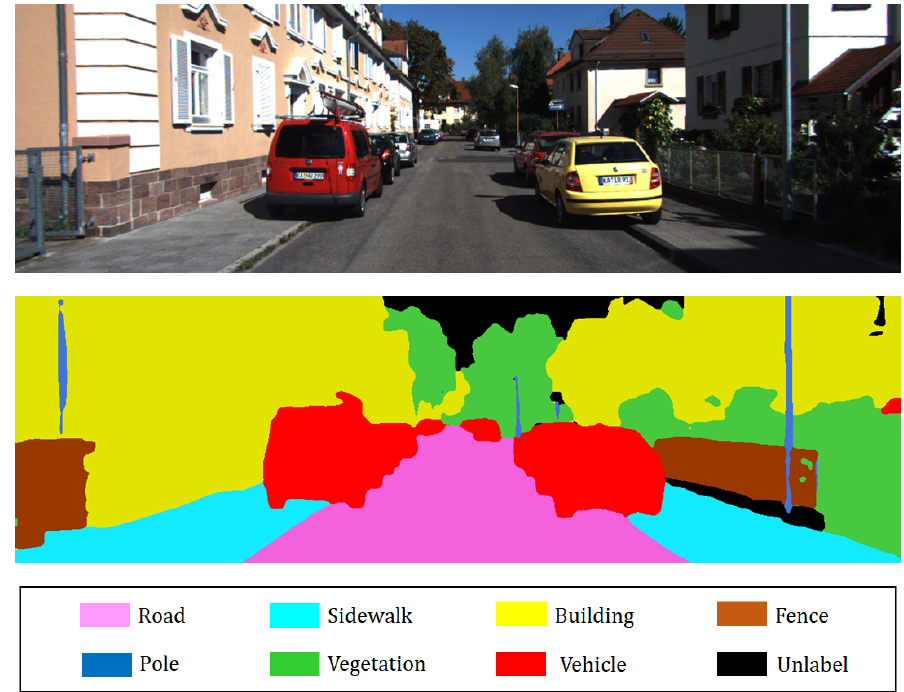
Figure 3. Example of 2D semantic segmentation: (Top) input image (Bottom)